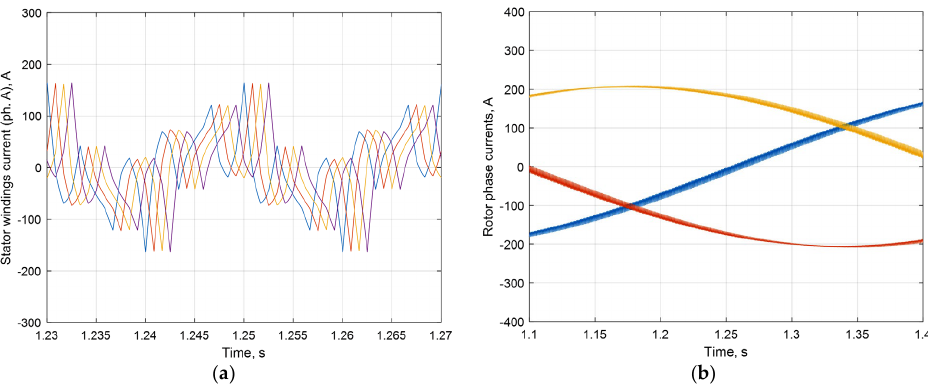
Figure 18. Rotor currents of 3PIM ( a ), rotor currents of 6PIM ( b ) in steady-state mode: ph. A—blue, ph. B—red, ph. C—yellow.